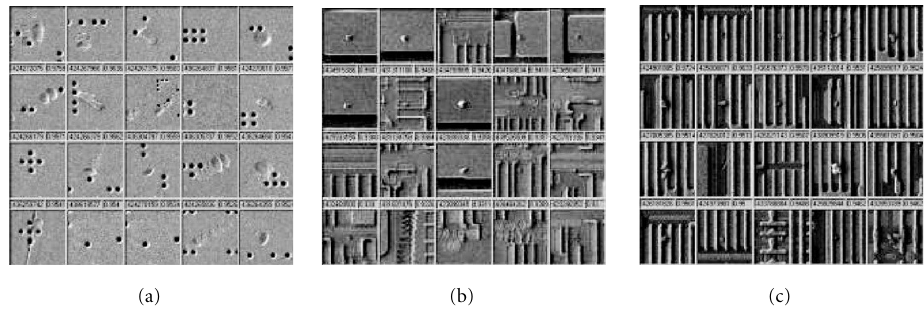
Figure 8: Examples of SEM image query results for three di ff erent substrates on a semiconductor device. Note that the query image in (a), (b), and (c) are always the upper left image in the matrix.